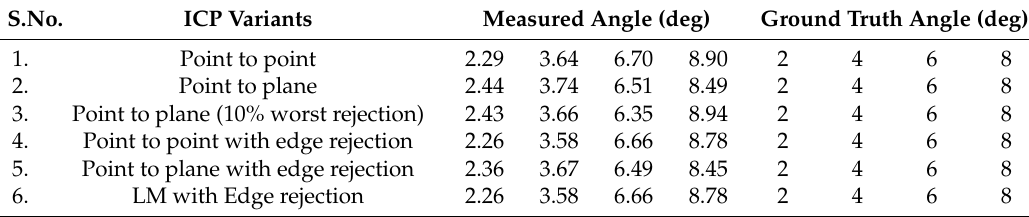
Table 3. Accuracy of the proposed ICP algorithm and its comparison with the other variants. S.No. ICP Variants Measured Angle